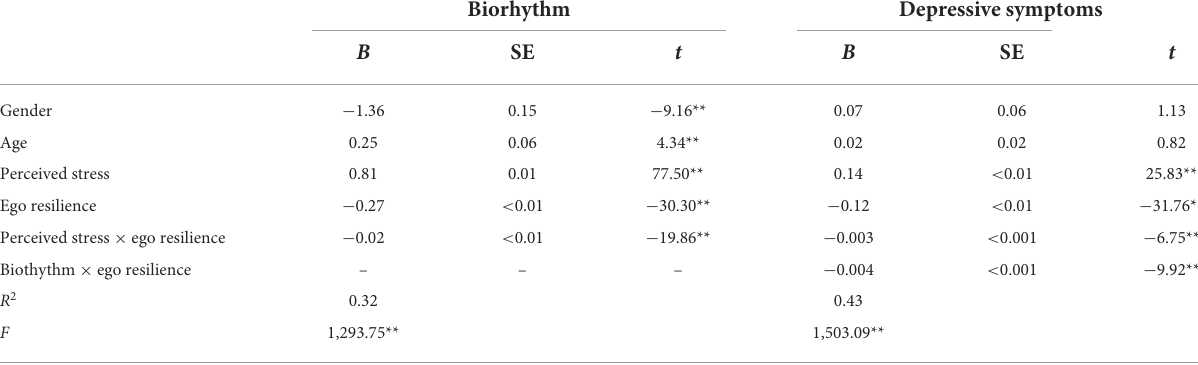
TABLE 4 Moderated mediation